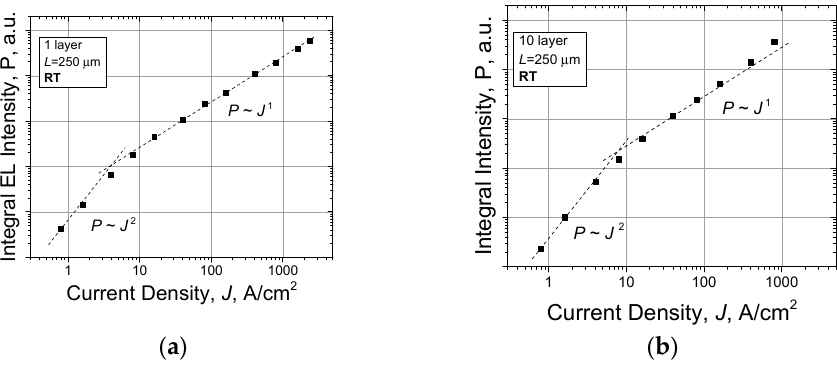
Figure 14. Dependencies of integral electroluminescence intensity on the current density for lasers based on ( a ) 1 QWD layer, and ( b ) 10 QWD layers.